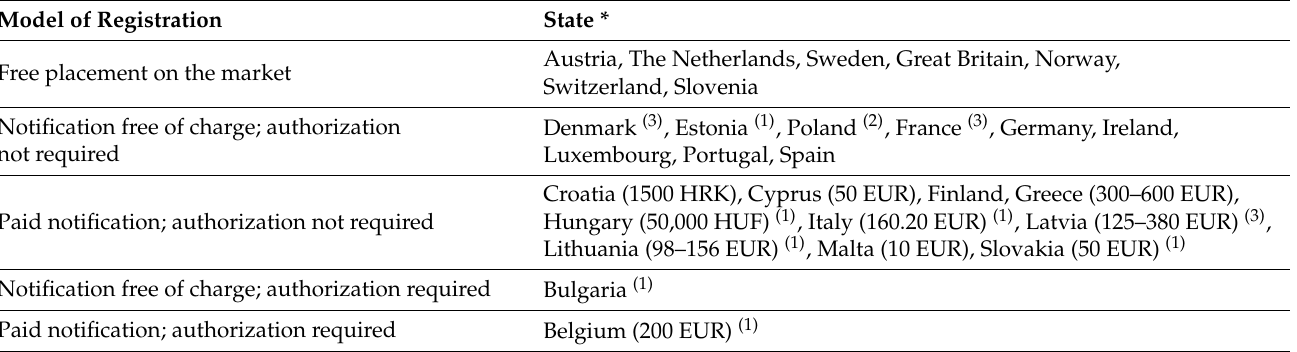
Table 1. List of monitoring systems of dietary supplements placed on the marked for the first time in selected Member States of the European Union and EEA, and in Great Britain as of June